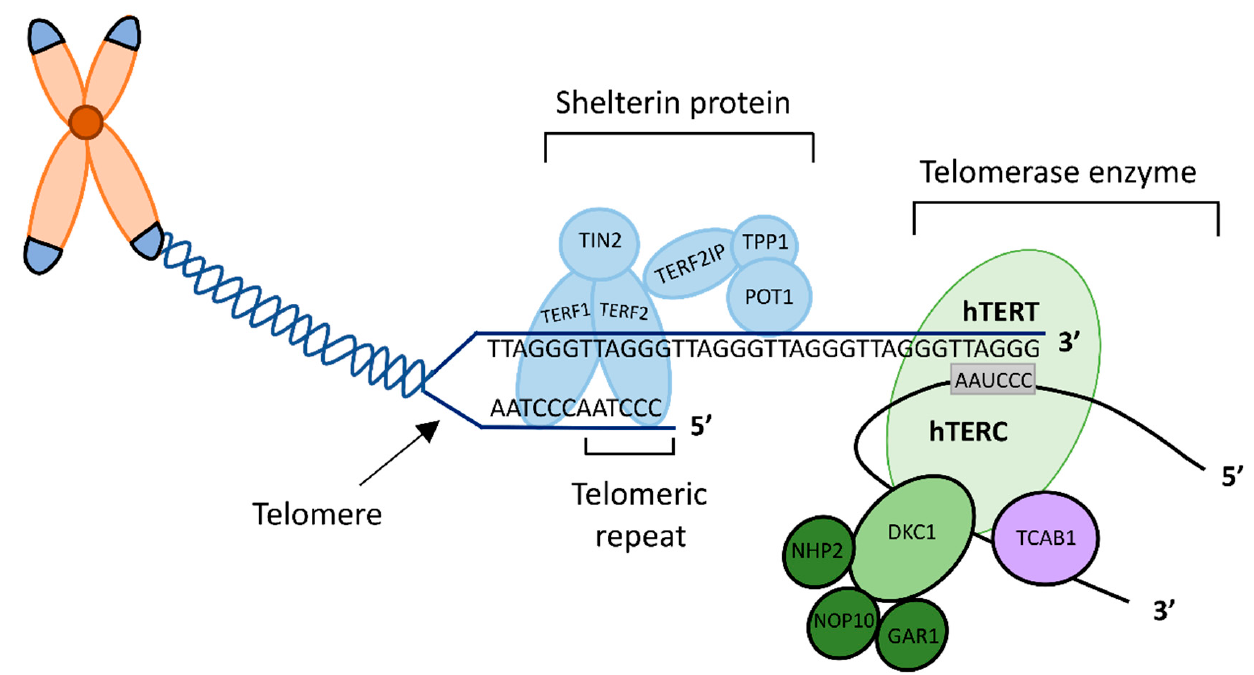
maintenance (TM) is an essential cellular function.